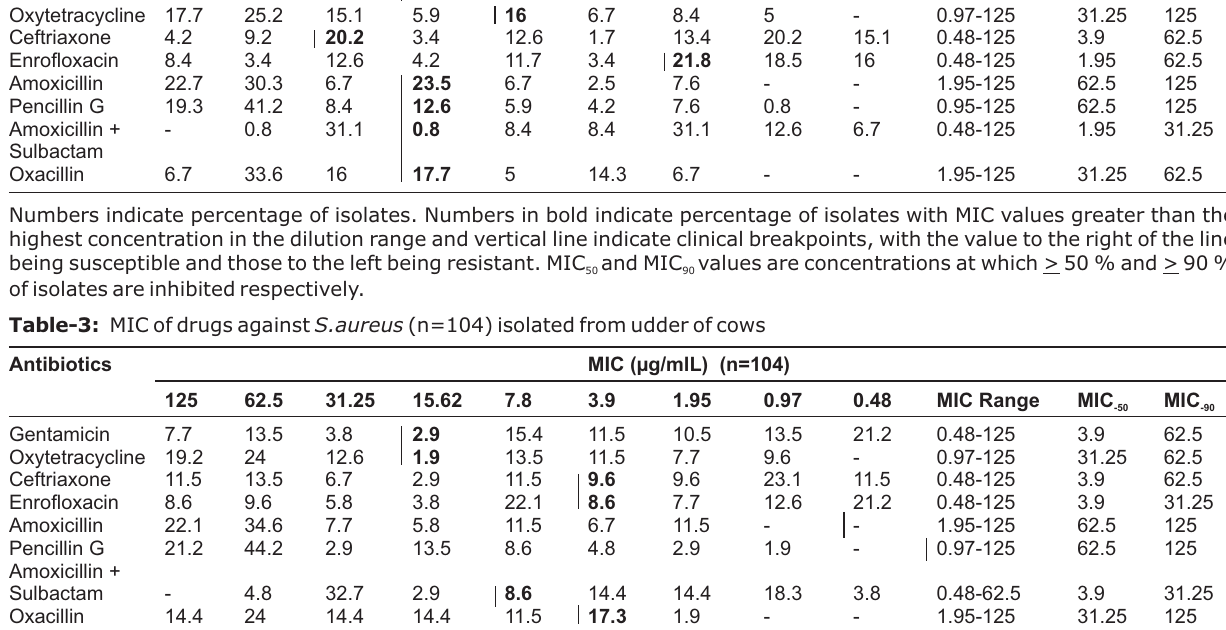
Numbers indicate percentage of isolates. Numbers in bold indicate percentage of isolates with MIC values greater than the highest concentration in the dilution range and vertical line indicate clinical breakpoints, with the value to the right of the line being susceptible and those to the left being resistant.MIC and MIC values are concentrations at which 50 % and 90 % of isolates are inhibited